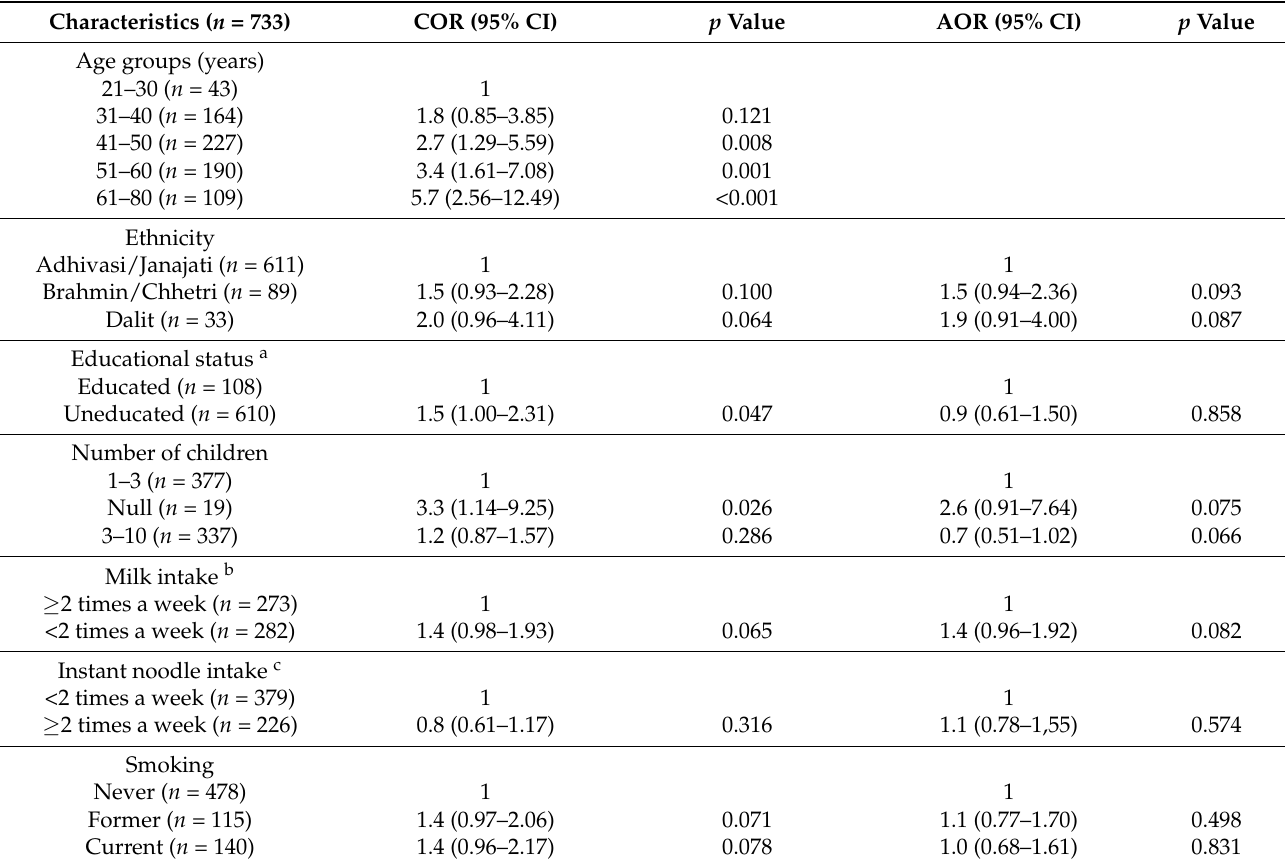
Table 5. Factors associated with hypovitaminosis D in the study